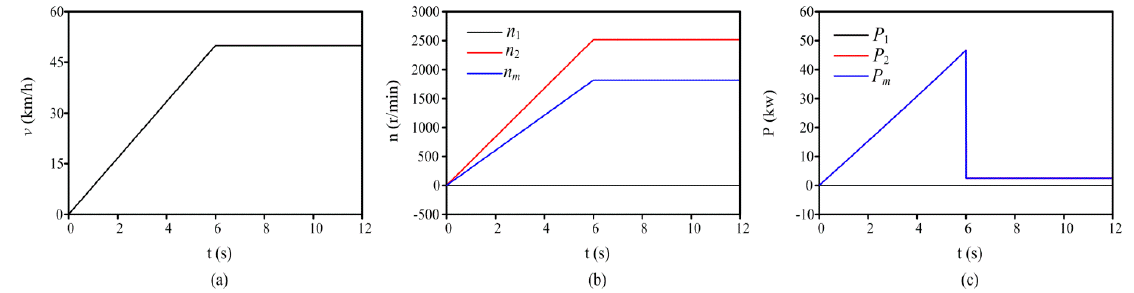
Figure 6. Mode 1: ( a ) Required vehicle velocity; ( b ) Rotational speeds; ( c ) Powers.